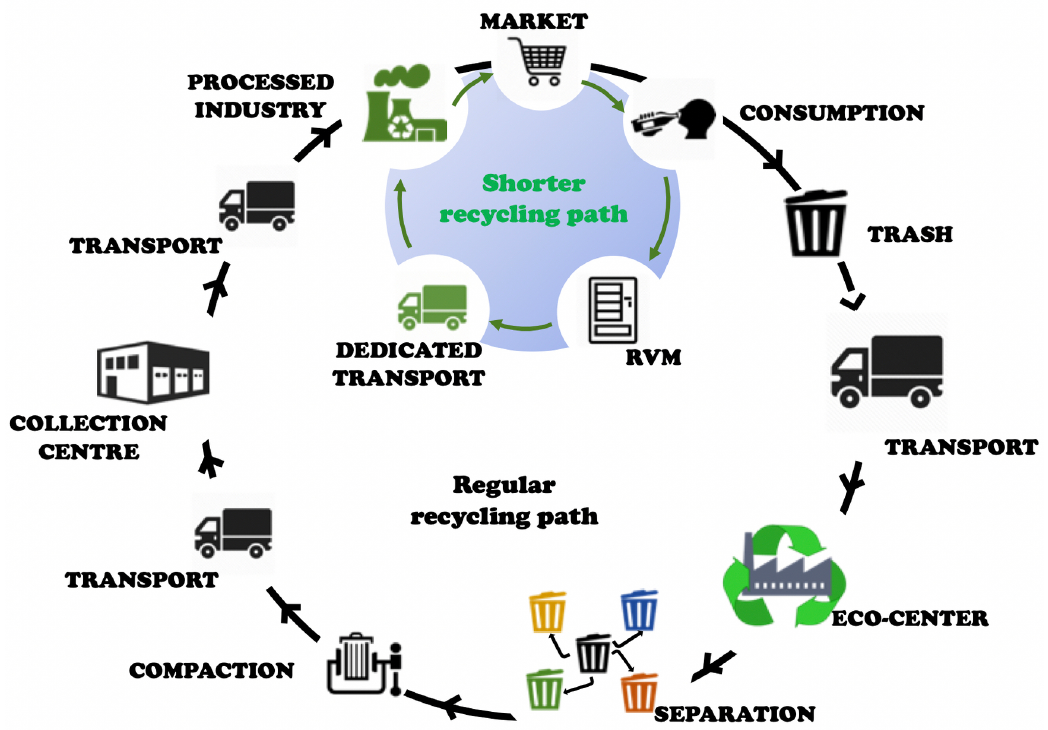
Figure 2. Regular and shorter chains of recycling: shorter chain should reduce environmental impact and ensures valorization of